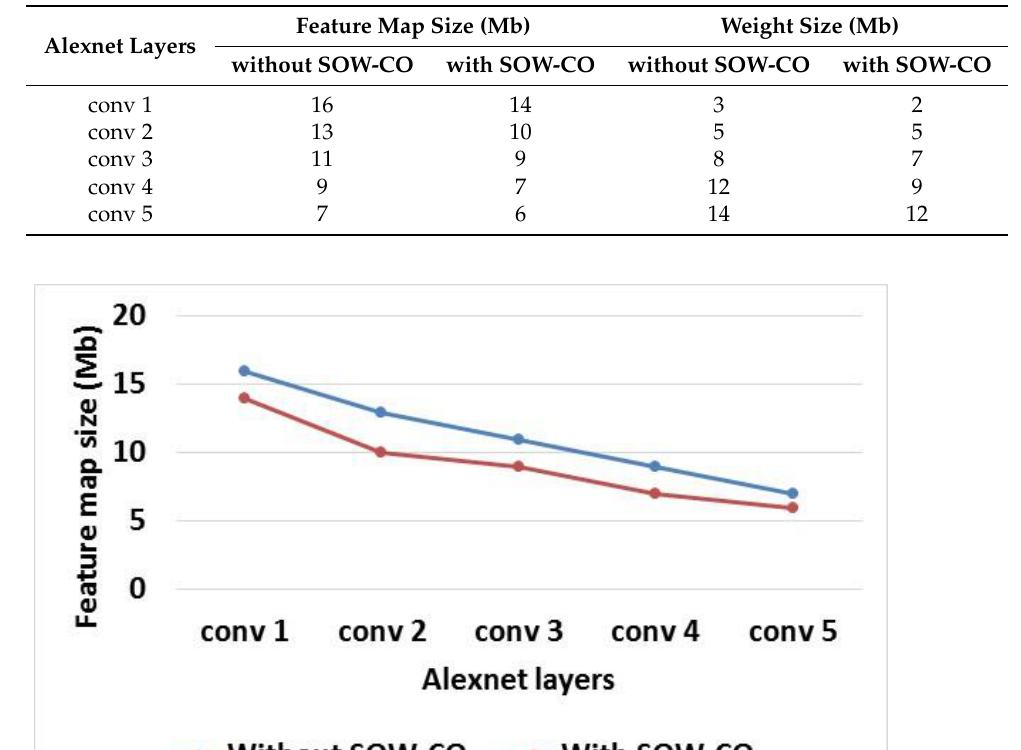
Table 2. Analysis of feature map and weight sizes for Alexnet.